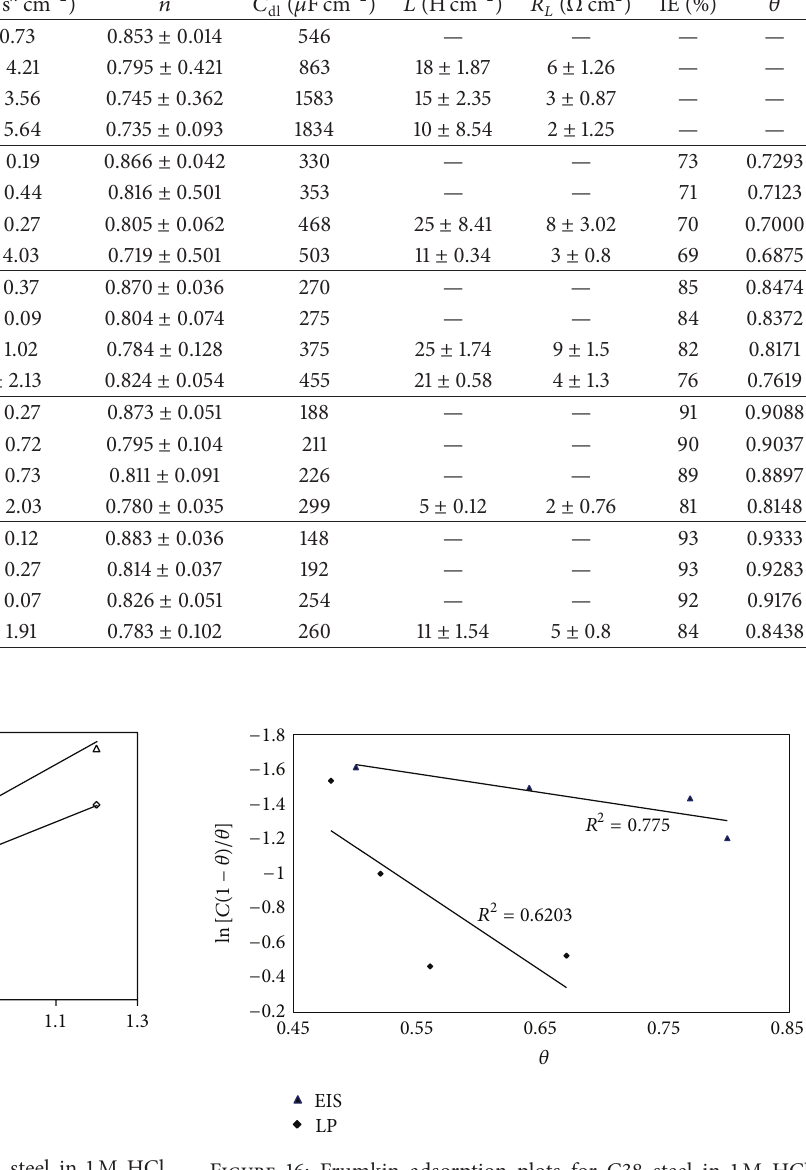
Figure 16: Frumkin adsorption plots for C38 steel in 1M HCl containing different concentrations of norharmane at 55 ∘